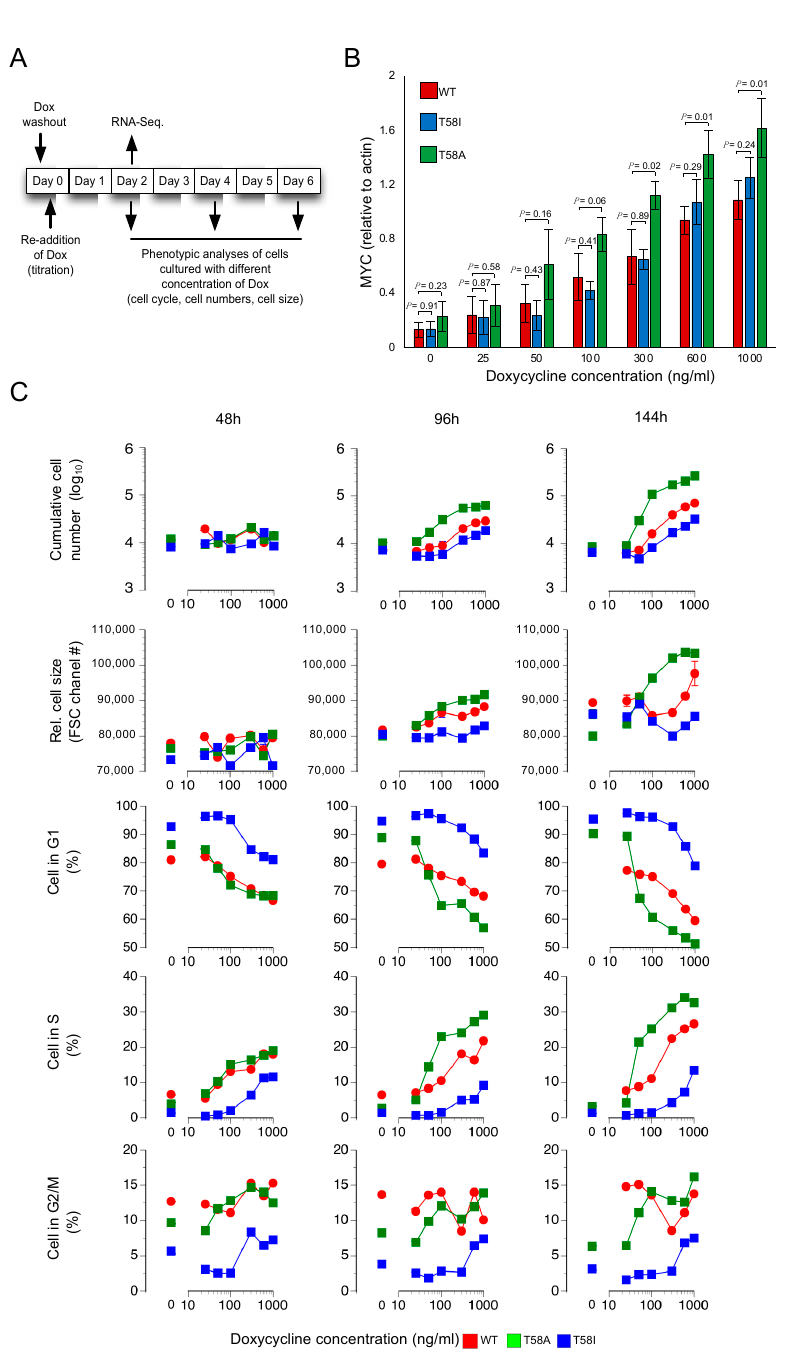
Figure 1. Phenotypic characterization of immortal B-cells expressing doxycycline regulatable MYC. ( A ) Experimental setup, time points for doxycycline wash out and re-addition as well as time points for data collection and RNA sampling ( B ) MYC protein levels at different levels of doxycycline in culture medium (0, 25, 50, 100, 300, 600 and 1000 ng/mL) assessed by Western Blot for WT MYC (red), T58A MYC (green) and T58I MYC (blue) in relation to actin levels. Mean ± SD ( n = 3) is shown. ( C ) Flow cytometry data for WT MYC (red), T58A (green) and T58I (blue) sampled at 48, 96 and 144 h following addition of doxycycline at 0, 25, 50, 100, 300, 600 and 1000 ng/mL. From top to bottom, the panels represent: cumulative live cell number, relative cell size estimated by the forward scatter channel (FSC) and G 0 /G 1 , S and G 2 /M cell cycle stage assessment for cells stained with propidium iodide (percentages). The data are from a single experiment. Similar data for the 48 h time point (used for RNA sequencing experiments) were obtained in a separate